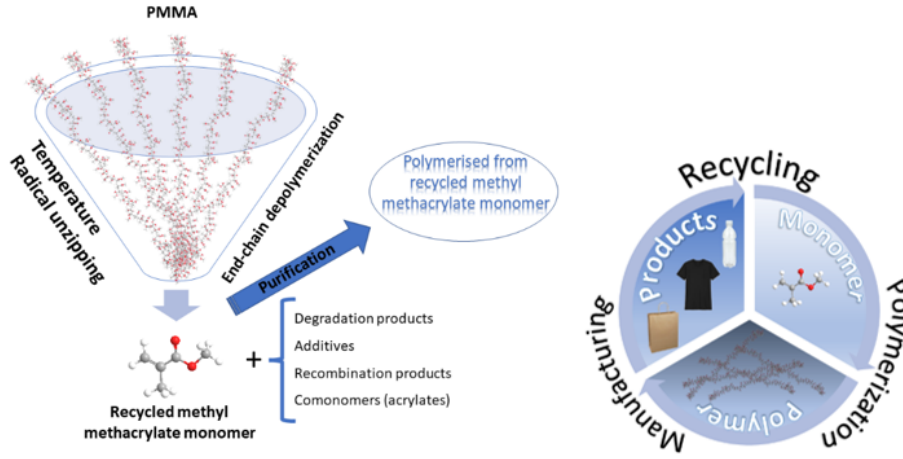
Figure 16. PMMA depolymerisation chemistry.